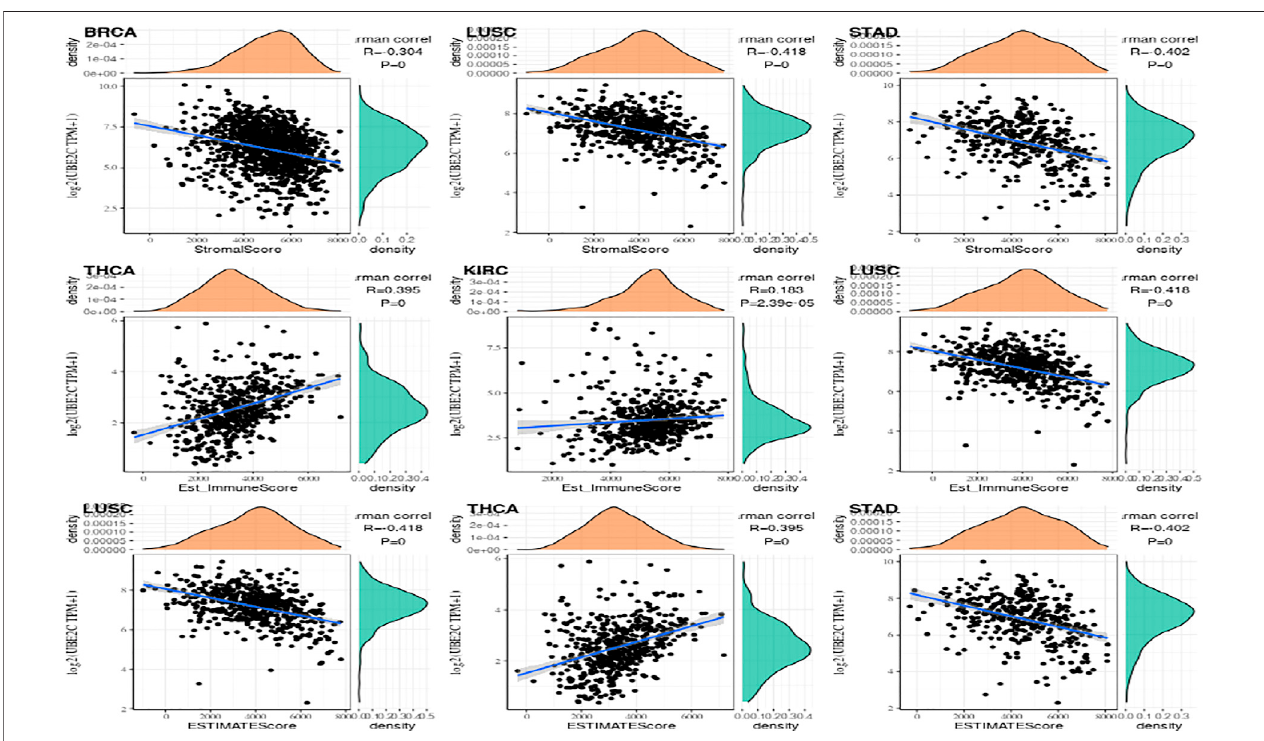
FIGURE 9 | The top 3 tumors that are most signi fi cantly